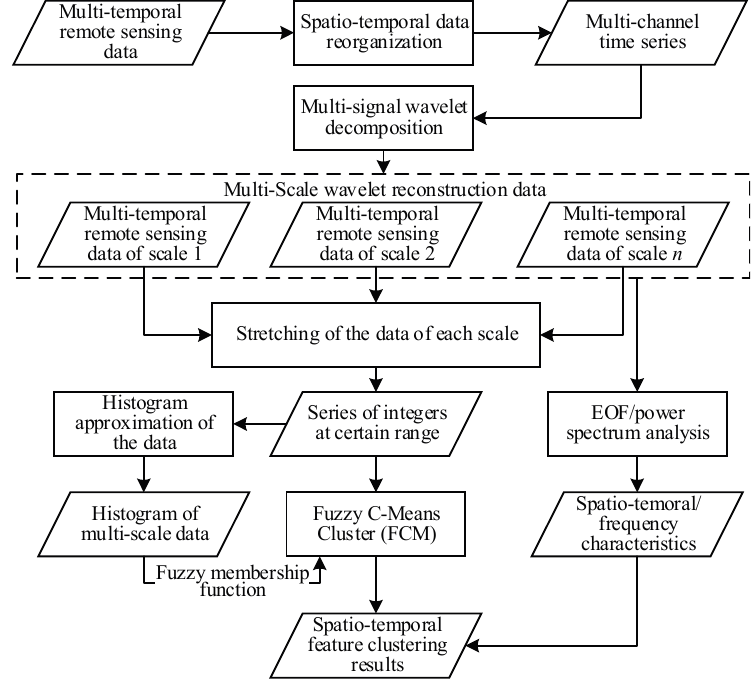
Figure 2. The processing